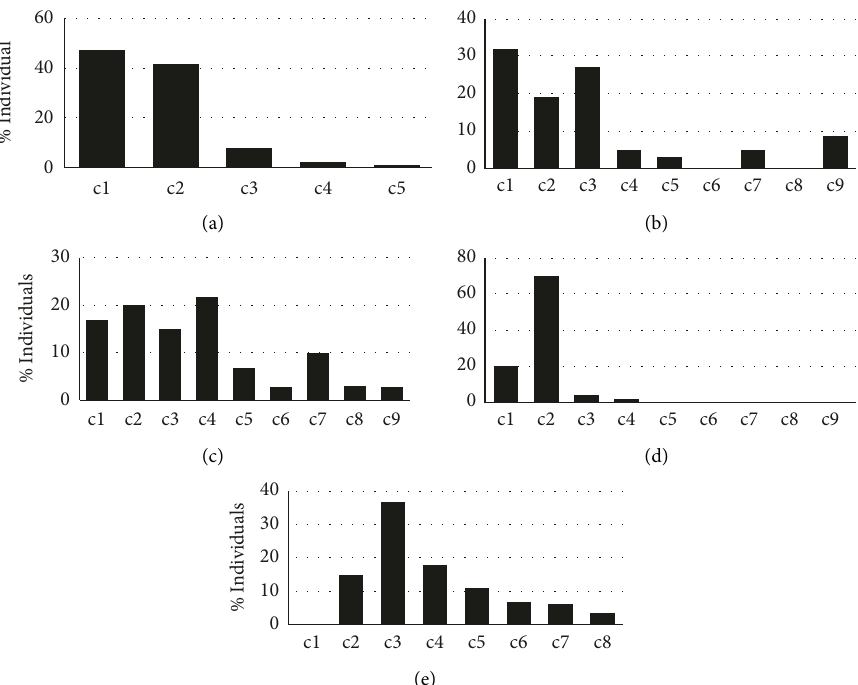
Figure 5: Population patterns of representative individual tree species: C C 5 � 11.1cm–14cm, C 6 � 14.1cm–17cm, C 7 � 17.1cm–20cm, C 8 � 20.1cm–23cm, C 9 � 23.1cm–26cm, C 10 � 26.1–29cm, C 11 � 29.1cm–32cm, and C 12 � > 32cm. (a) Dichrostachys cinerea . (b) Balanites aegyptiaca . (c) Combretum molle . (d) Acacia brevispica . (e) Acacia